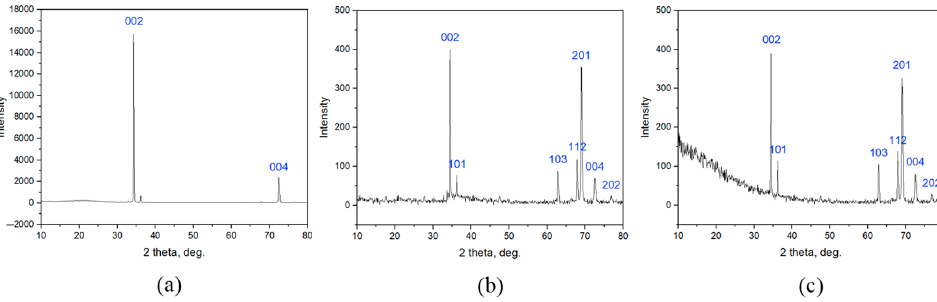
Figure 9. The XRD analysis results for the ZnO structures obtained by the PECVD method at the various temperatures in the reactor deposition zone: ( a ) 25 °C; ( b ) 250 °C; ( c ) 350 °C.